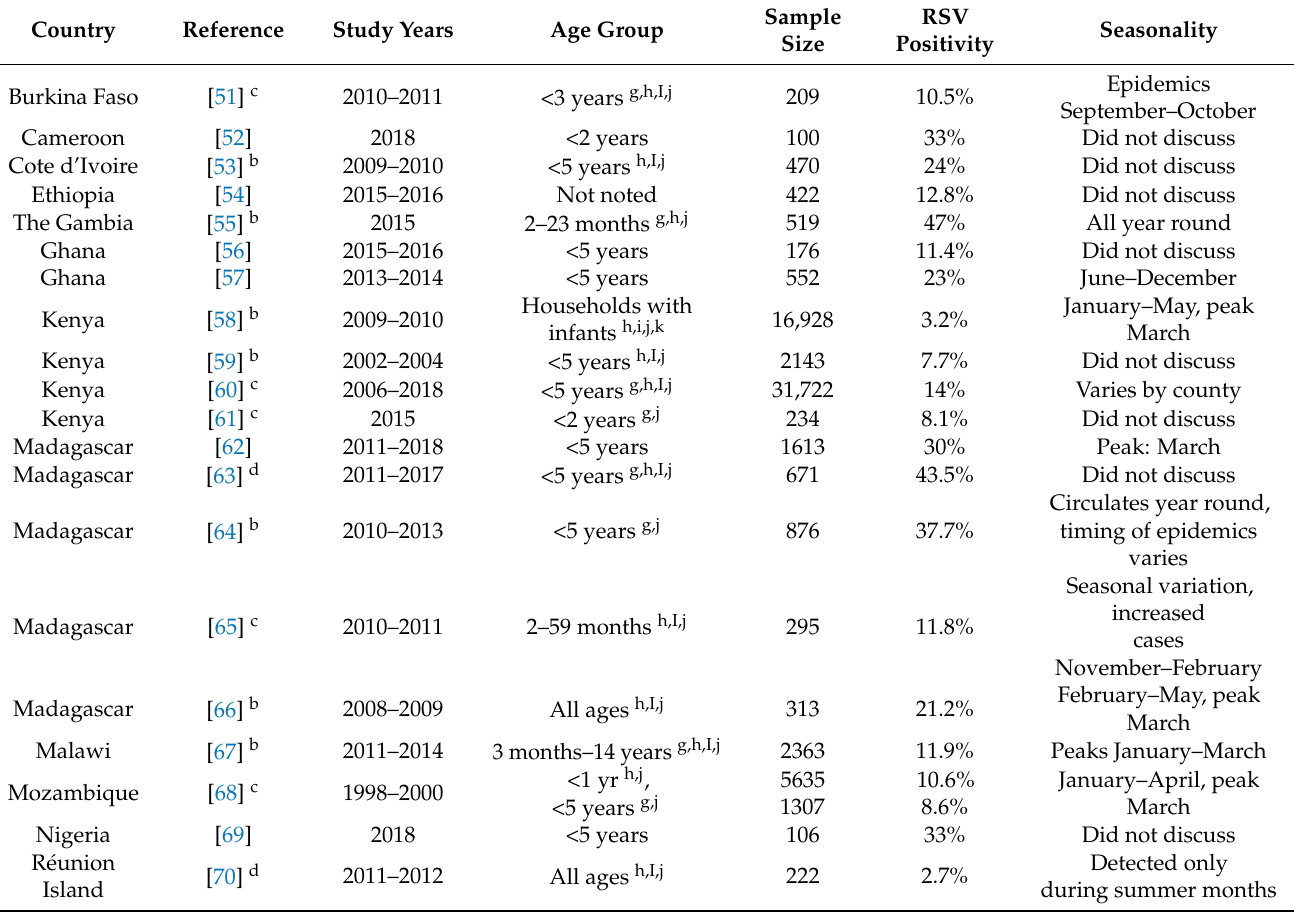
Table 2. RSV epidemiology in countries of tropical